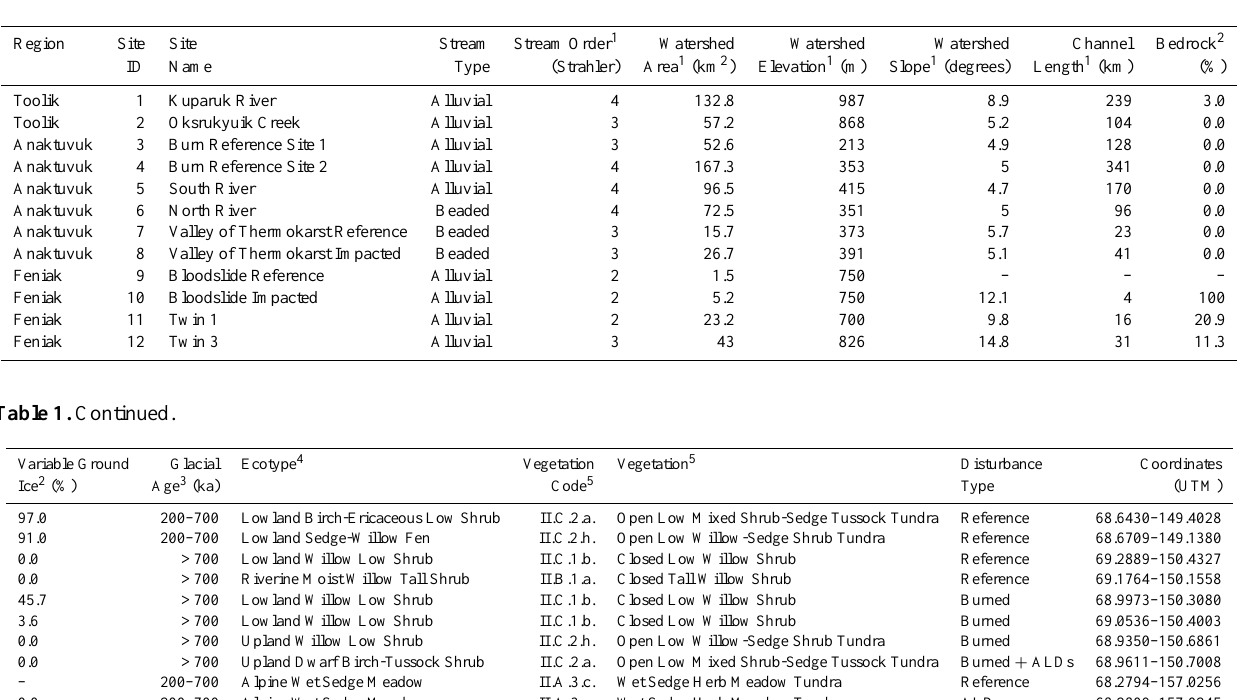
Table 1. Watershed characteristics of sampling